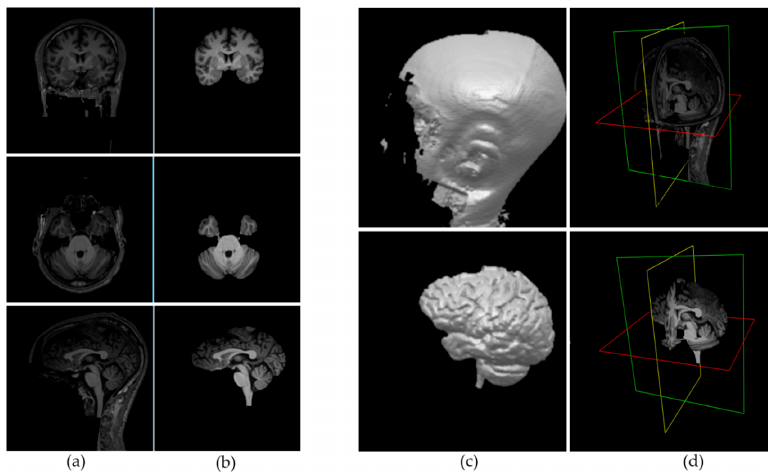
Figure 1. Skull stripping in brain MRIs. ( a ) Input 2D brain image in three orientations (coronal, axial, and sagittal), and ( b ) respective skull stripping in each image. ( c , d ) Similarly, the skull stripping in brain MRI volume (data from NFBS dataset